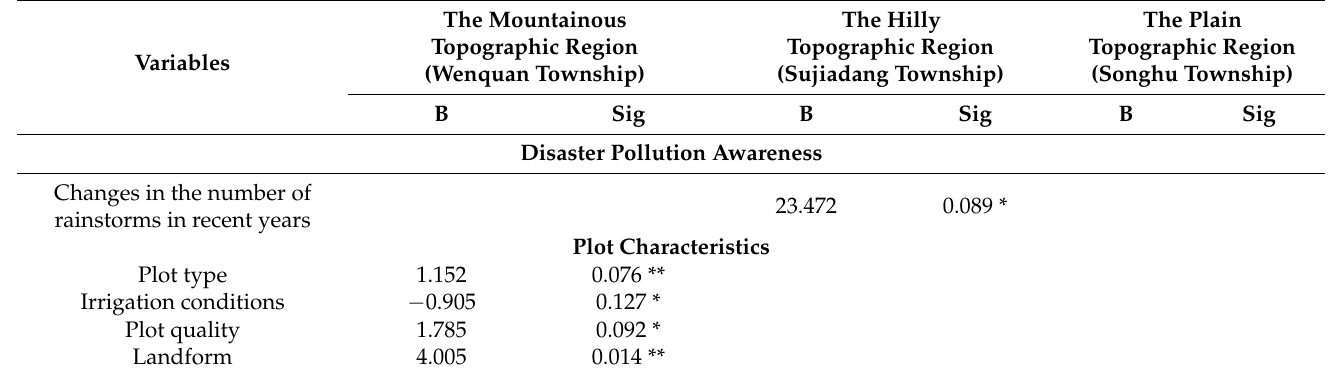
Table 13. Bootstrap sampling results of part-time households in three topographic